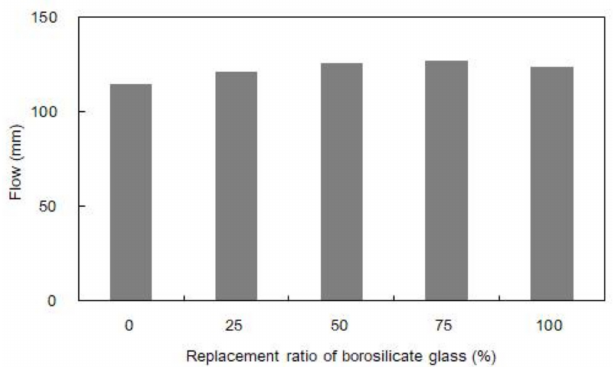
Figure 4. Flow of fresh cement mortar with borosilicate